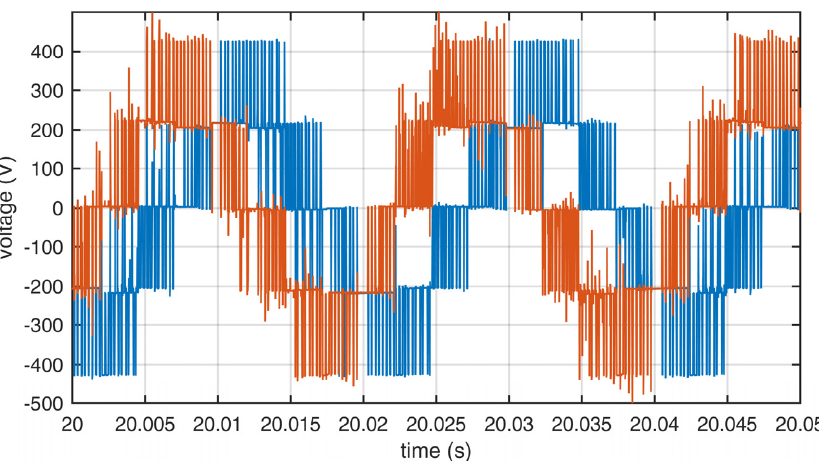
Figure 10. Output line voltages of the inverter using set C. Blue—L1, red—L2.